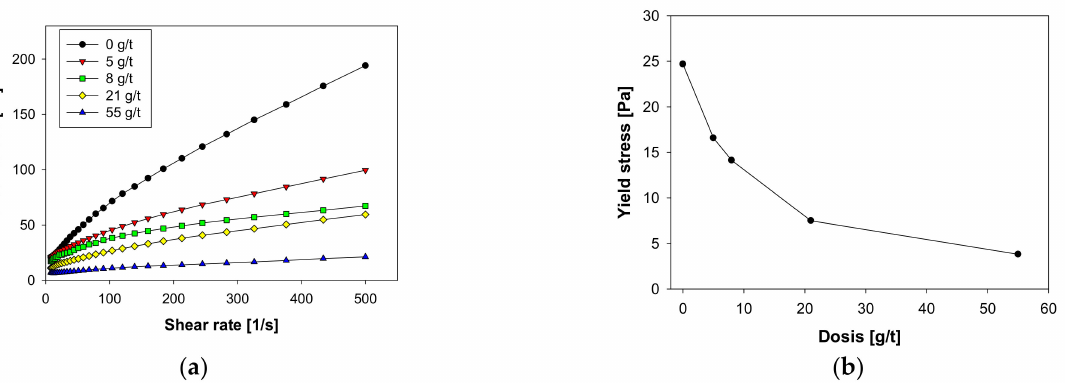
Figure 1. Impact of sodium metasilicate on the rheological behavior of Hematite suspensions in 0.01 M NaCl. ( a ) Full rheogram, ( b ) Yield